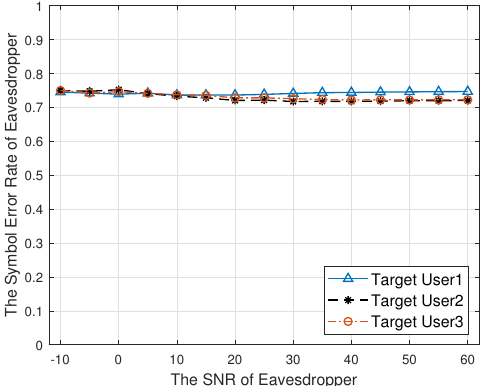
Figure 13. The symbol error rate against the SNR of the eavesdropper.